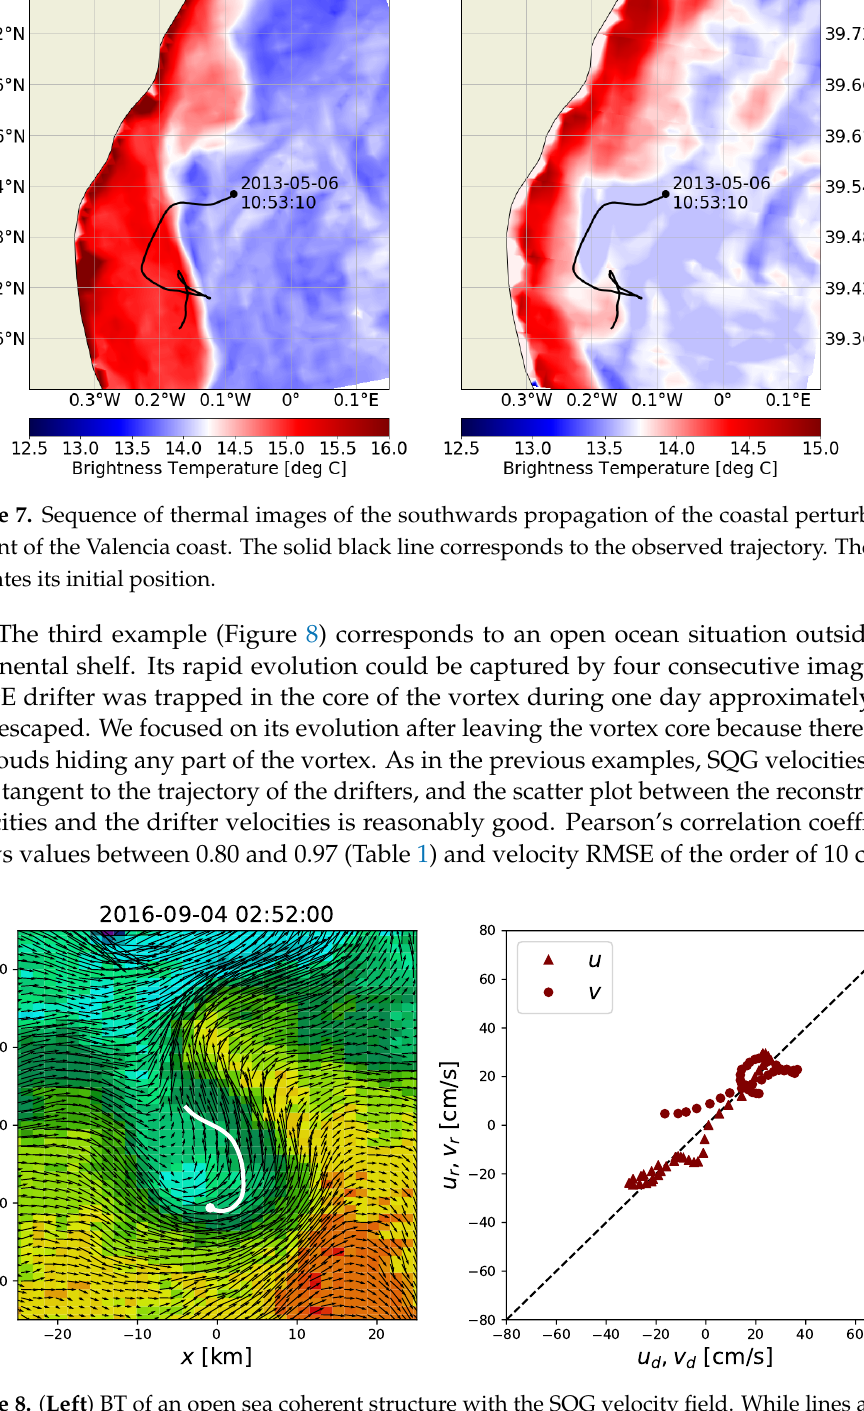
Figure 8. ( Left ) BT of an open sea coherent structure with the SQG velocity field. While lines are the segments of drifters trajectories used in the metrics of Table 1 and the scatter plots at right. ( Right ) scatter plot between velocities derived from drifters and those obtained from the BT images. The white region delimitates approximately the coastal